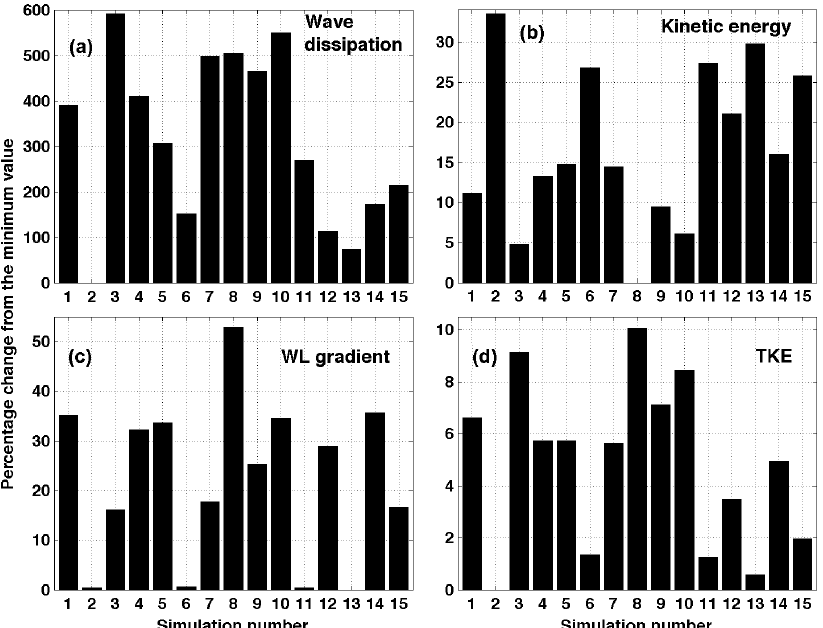
Figure 3. Percentage change from minimum for the four impact parameters: (a) wave dissipation; (b) kinetic energy; (c) maximum water level change (WL); and (d) turbulent kinetic energy